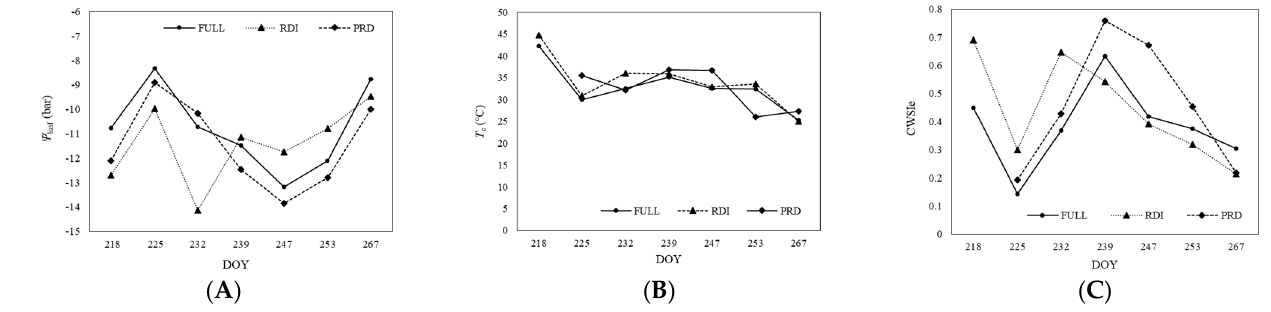
Figure 6. Seasonal variation of ( A ) midday leaf water potential ( Ψ leaf ); ( B ) canopy temperature ( T c ); and ( C ) empirical crop water stress index (CWSIe) for three water stress irrigation regimes in field-grown Riesling grapevines.